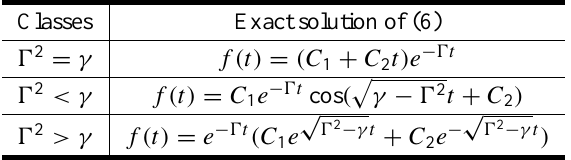
Potential functions.